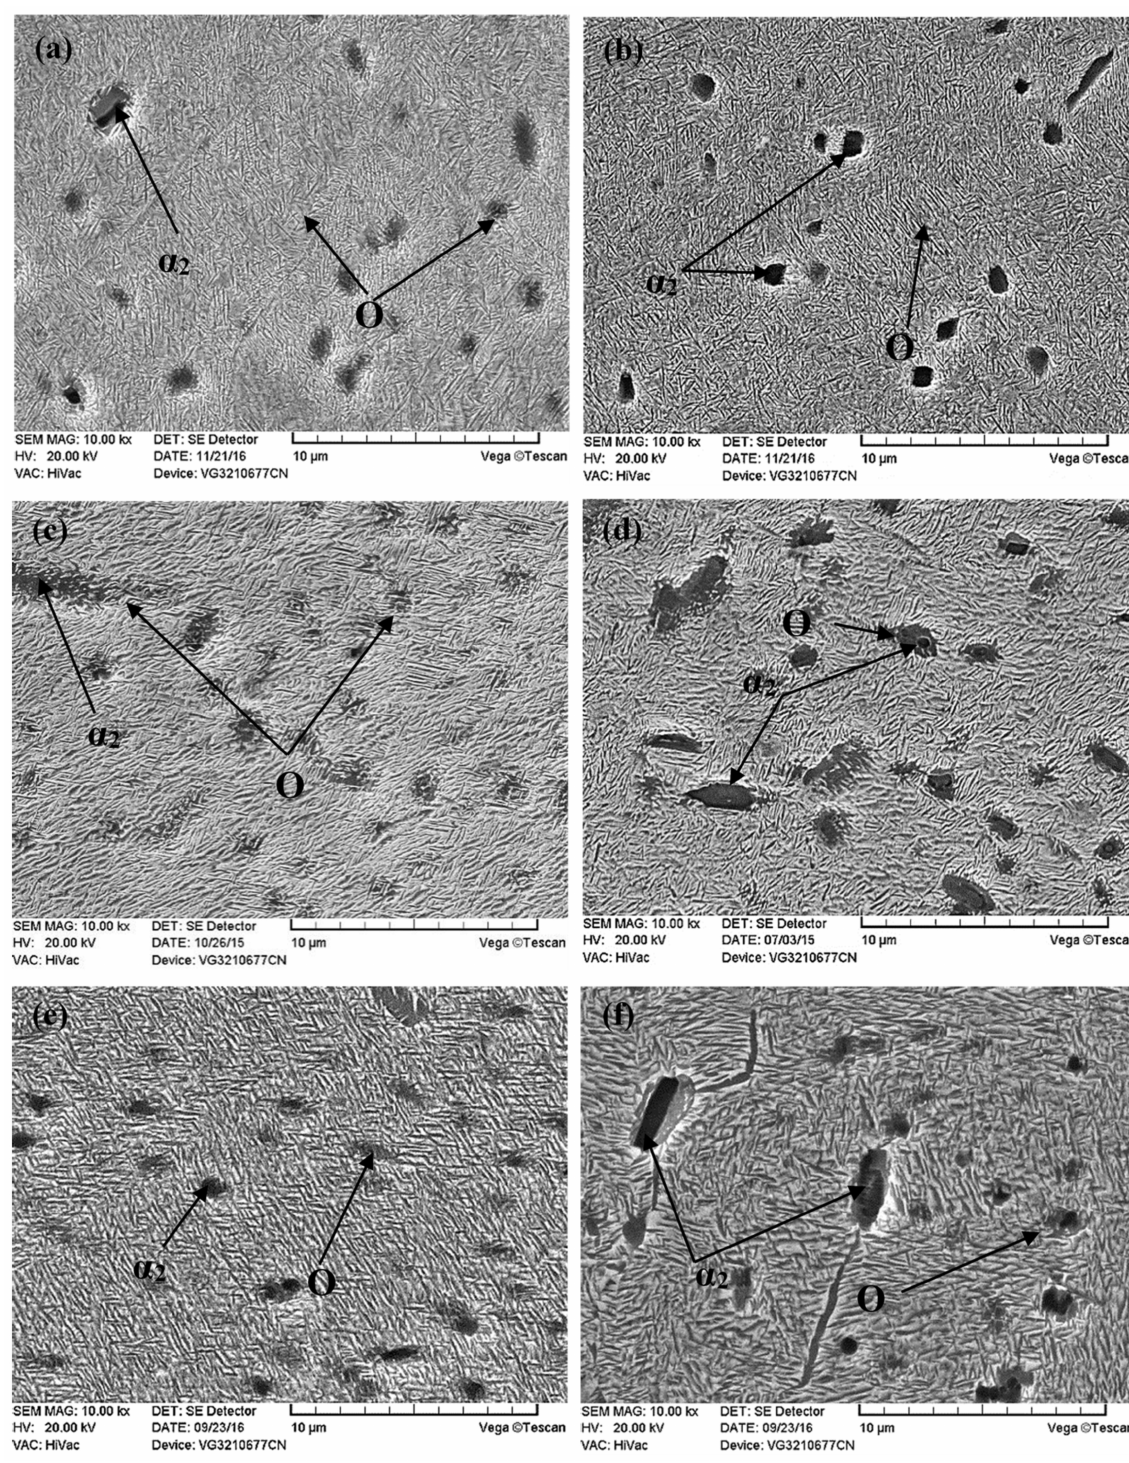
Figure 12. Micrographs of TMAZ by SEM: ( a ) near-weld zone and ( b ) far-weld zone after 760 ◦ C aging, ( c ) near-weld zone and ( d ) far-weld zone after 800 ◦ C aging, ( e ) near-weld zone and ( f ) far-weld zone after 840 ◦ C aging. Most α 2 + O mixtures still retain the equiaxed form indicating the insufficient decom- position of α 2 phase at 760 ◦ C. With the aging temperature rising to 800 and 840 ◦ C, the α 2 + O mixtures in the near-weld zone has almost been transformed into the acicular O phase. The microstructure characteristics of the far-weld zone after aging treatment at different temperatures are given in Figure 12b,d,f. It can be seen that the transformation